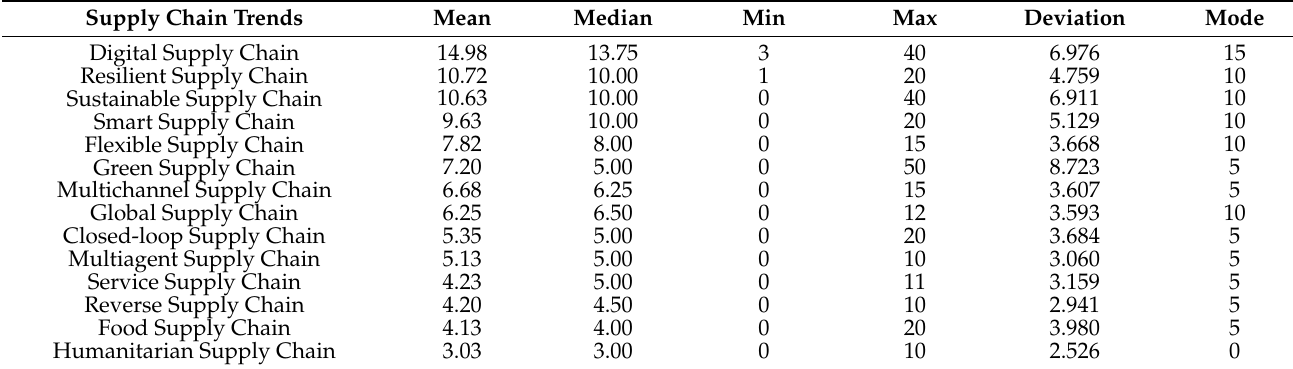
Table 3. Final results of opinions about global theoretical trends and supply chain development directions in the context of the dynamic development of technology and production organization (Industry 4.0) according to the experts’ assessments 1–30; own elaboration based on the conducted research.